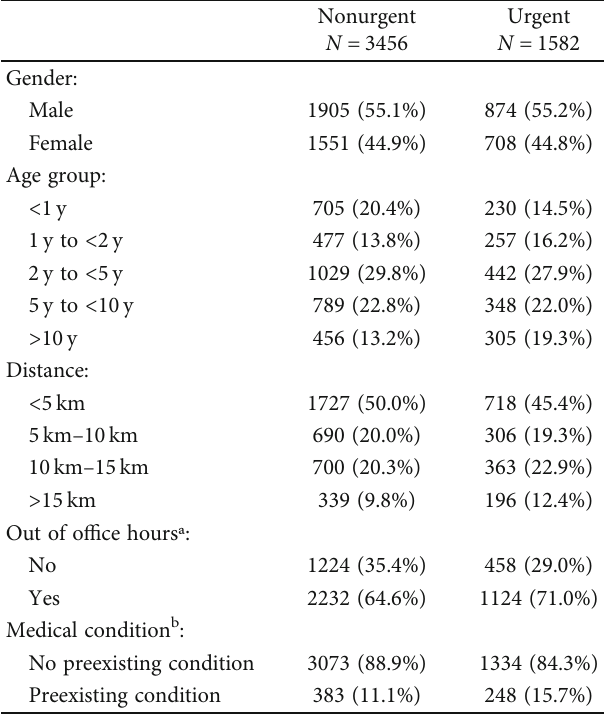
Table 1: Distribution of patients including age, gender, assessment of urgency, and distance to the pediatric ED in 2017.